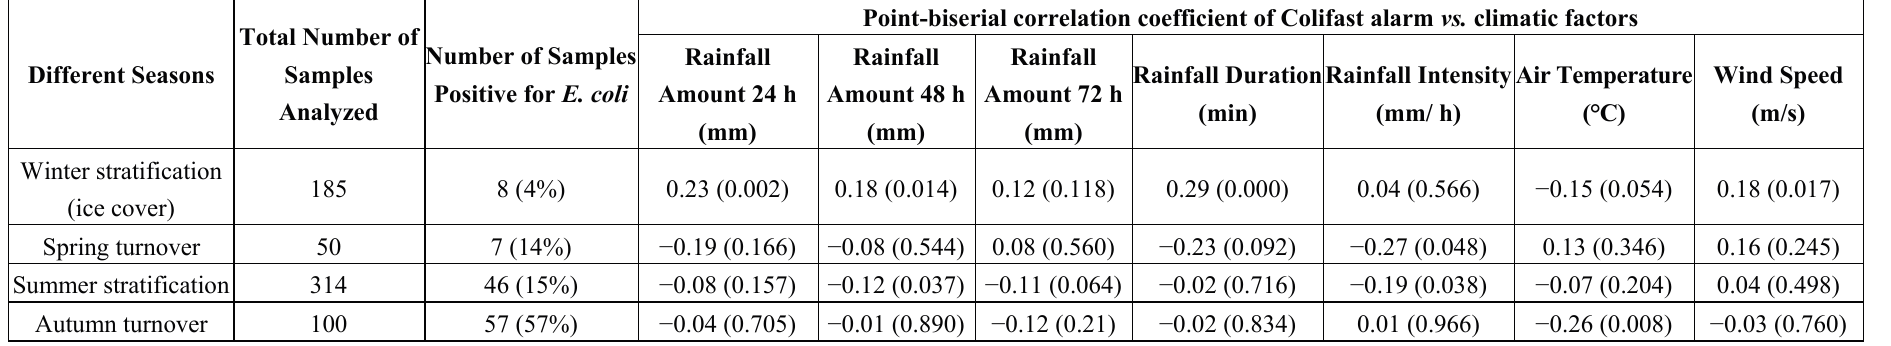
Table 3. Summary of the detection of Escherichia coli in the raw water (daily samples analyzed by ALARM) in relation to season (temperature stratification/turnover in the lake) and test of potential relationship between Escherichia coli detection and weather conditions in each